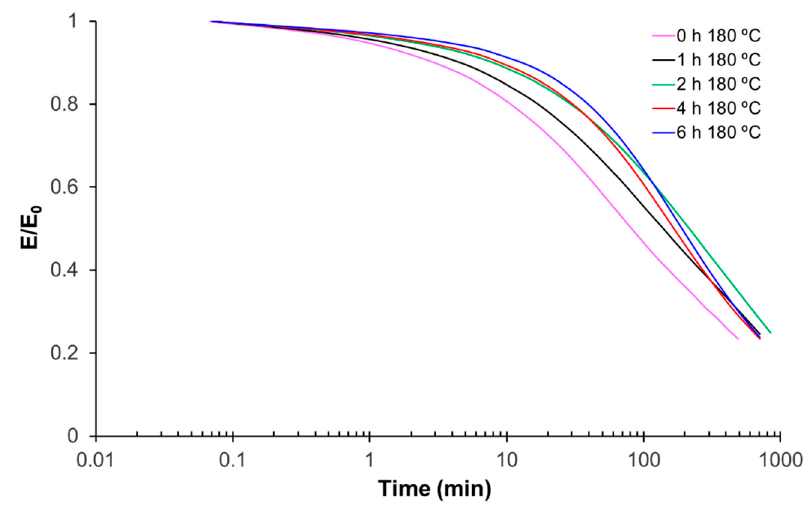
Figure 13. Stress relaxation behavior of FEMA 3D post ‐ treated at 180 °C for different durations.